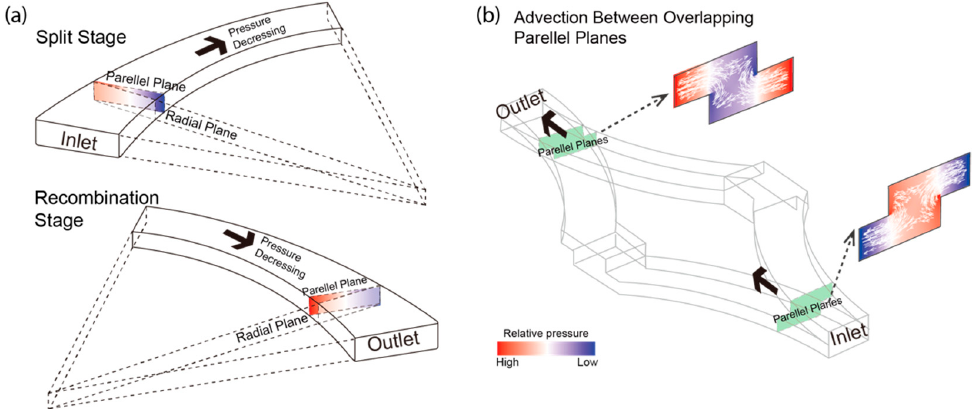
Figure 8. Mechanism of advection between overlapped curvature channels. ( a ) Schematic of pres- sure distribution in the inlet, outlet, radial plane, and parallel planes from the Split (upper) and Recombination (lower) stage of the mixing process. The pressure gradients in the parallel planes are different depending on the mixing stage. ( b ) The pressure gradient of parallel planes from overlapped channels induces advection between them, and the direction is consistent with separation and combination parts.